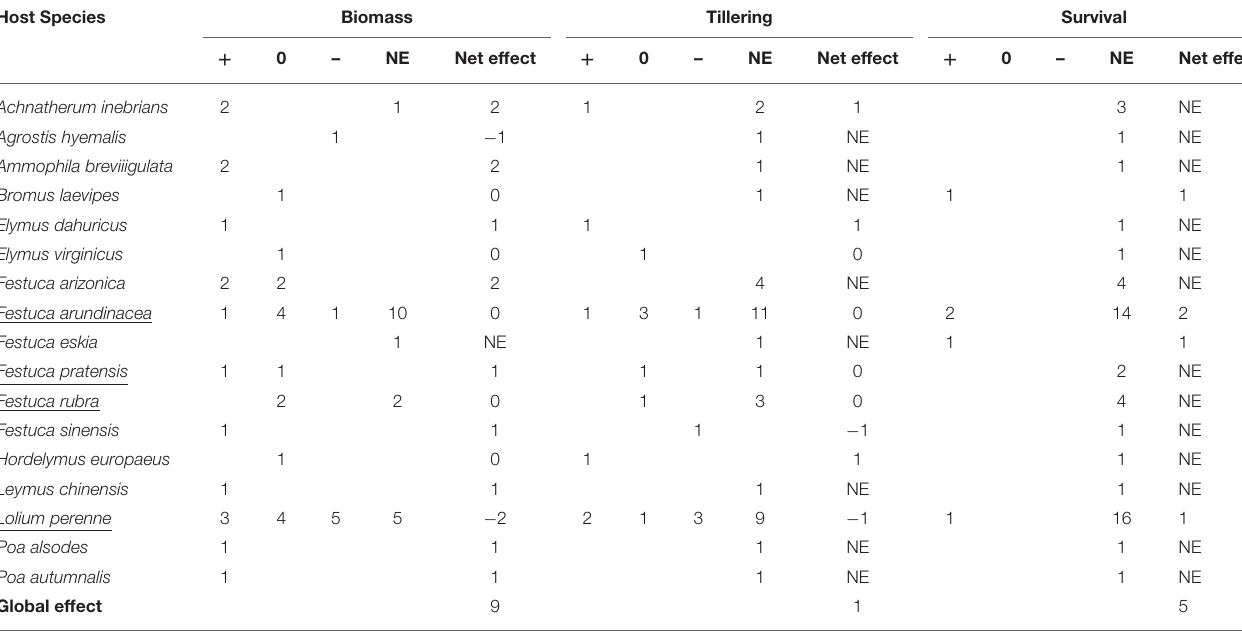
TABLE 1 | Summary table showing the number of experiments describing beneficial ( + ), neutral (0), or detrimental (–) effect of an Epichloë fungal endophyte on the host grass performance variables (biomass, tiller, and survival), under drought conditions. Host Species